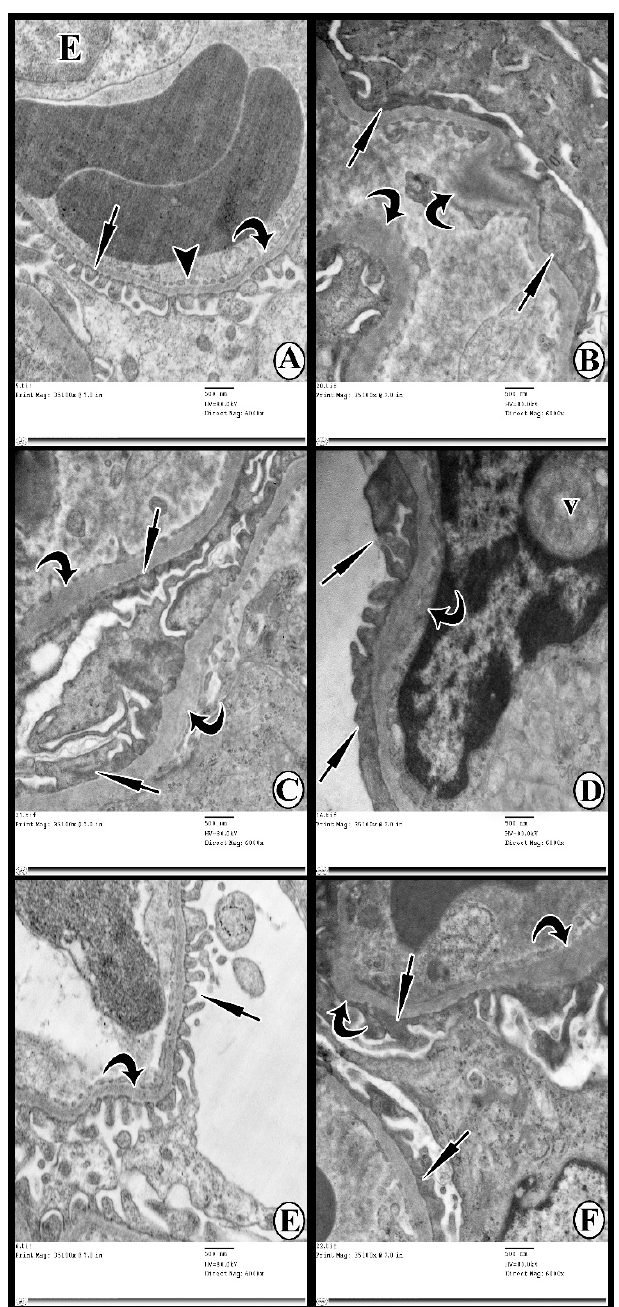
Figure 7. Ultrathin sections showing glomerular filtration barriers of ( A ) Group I, consisting of thin fenestrated endothelial cell (E; arrowhead), thin regular glomerular basement membrane (curved arrow), and the foot processes of the podocytes (short arrow). ( B ) Group IIa shows extensive fusion and effacement of the foot processes (short arrows) and diffuse thickening of the glomerular basement membrane (curved arrows). ( C ) Group IIb shows complete fusion and effacement of the foot processes (short arrows) and thickened glomerular basement membrane (curved arrows). ( D ) Group III shows areas of fusion and effacement of the podocytes (thin arrows) and diffuse thickening of the glomerular basement membrane (curved arrow). A vacuole (v) is seen compressing the nucleus of the endothelial cell. ( E ) Group IV shows thin regular glomerular basement membrane (curved arrow) and foot processes of podocytes (thin arrow). ( F ) Group V shows persistent fusion and effacement of the foot processes (short arrows) and thickening of the glomerular basement membrane (curved arrows) in some areas.